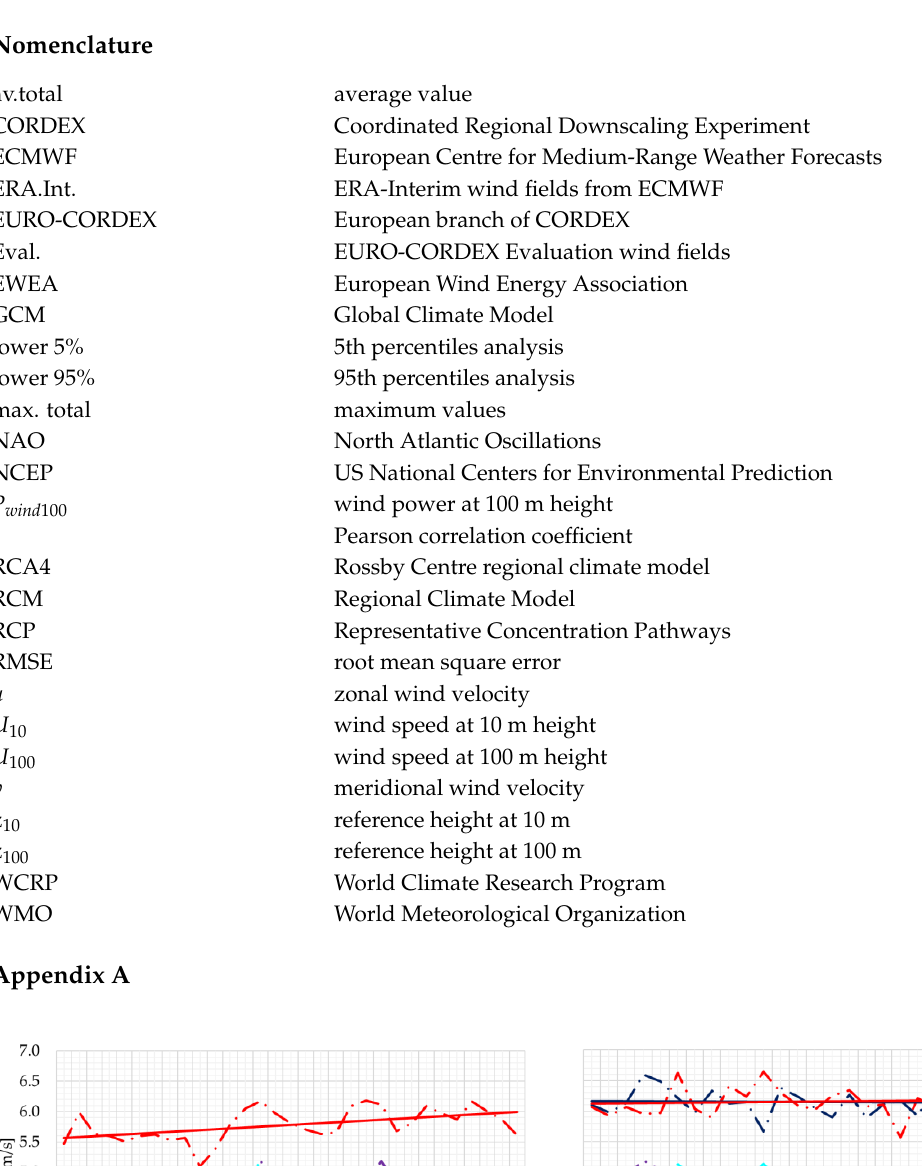
Figure A2. Annual averages of the wind speed at 10 m height for two of the most representative points located in shallow water (E.n.2) and in deep water (E.o.1) of Crimea Peninsula. ERA.Int and Eval data, time interval 1981–2010, RCP4.5 and RCP8.5 data, time interval 2021–2050.